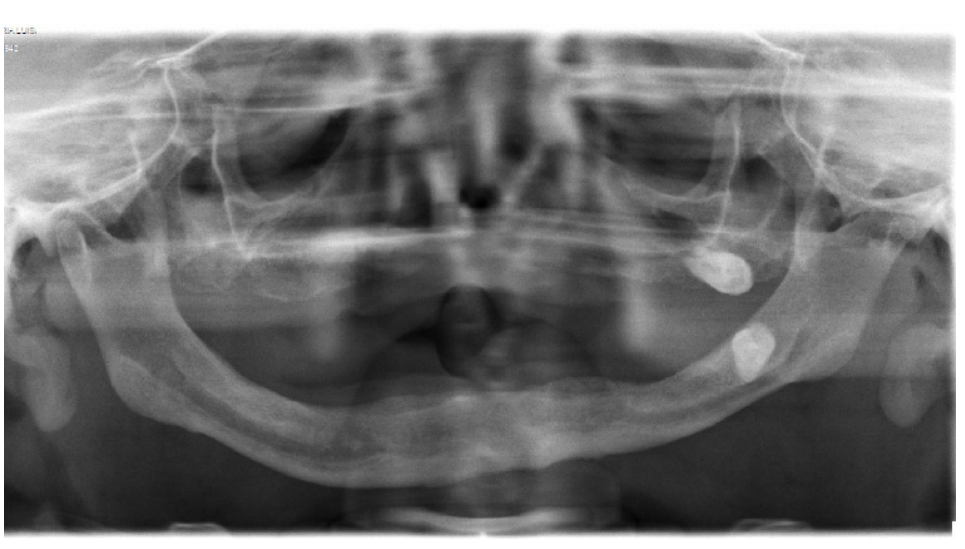
Figure 5. Orthopantomography of